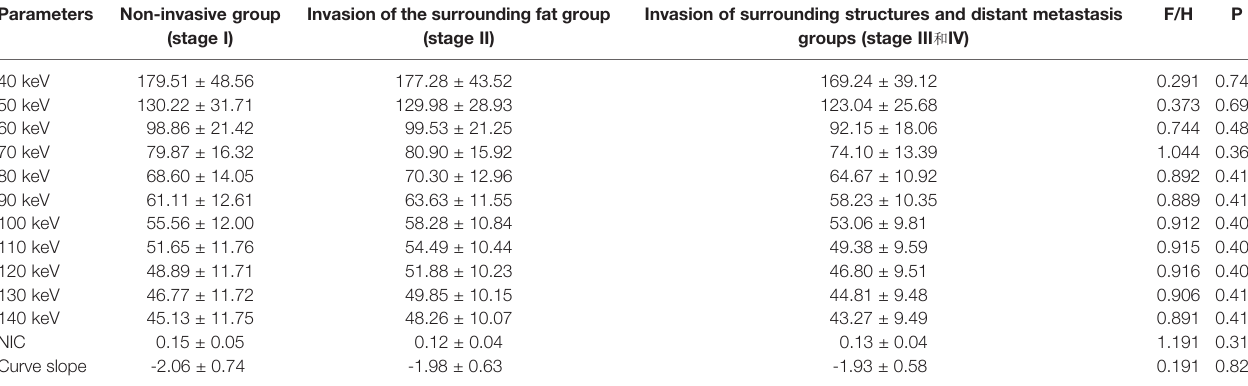
TABLE 1 | Spectral CT multi-parameter results of the three groups in stages (Arterial phase). Parameters